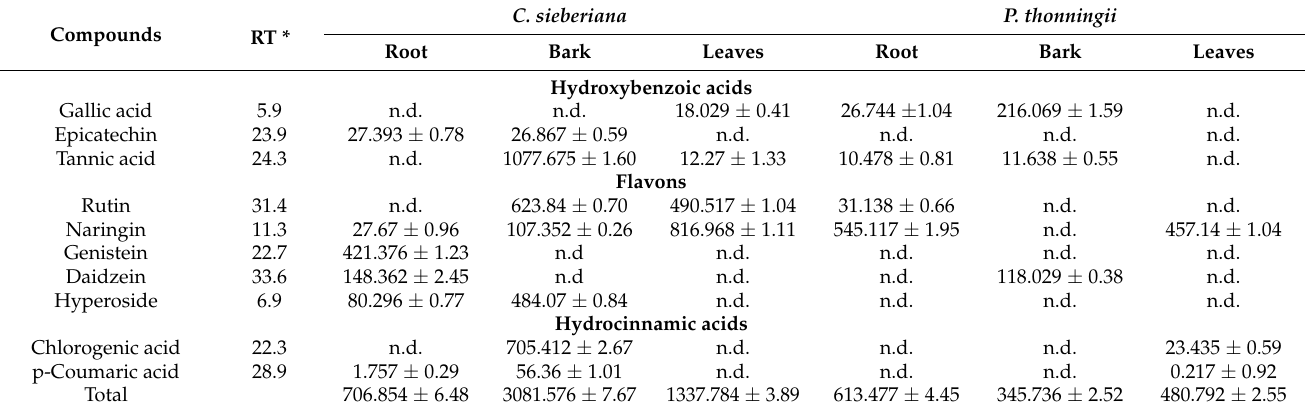
Table 1. Chemical composition of C. sieberiana and P. thonningii extracts (expressed as µ g/mL and ±